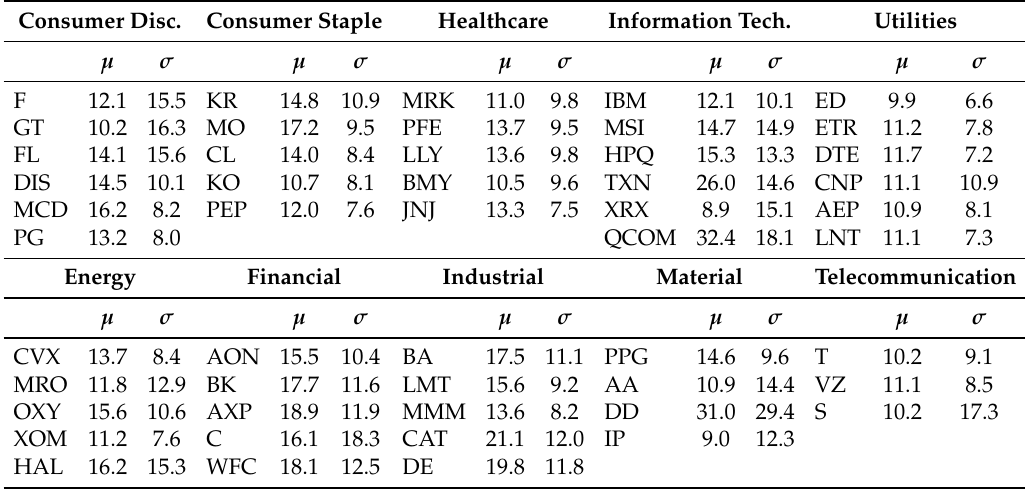
Table 1. Summary of assets and estimated annualized properties between 1992–2018. Consumer Disc. Consumer Staple Healthcare Information Tech.